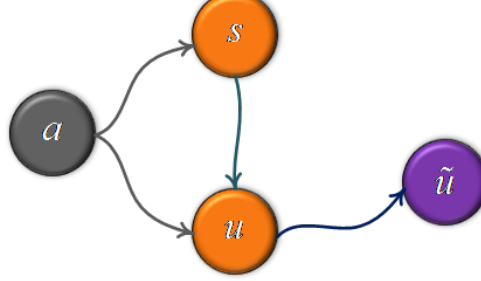
Figure 3. A typical Bayesian network for